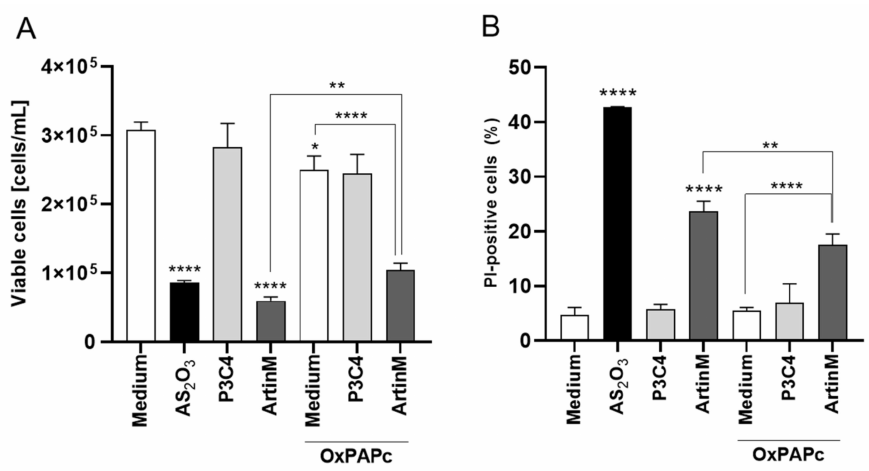
Figure 6. TLR-2 signaling blockaged by OxPAPC reduced the Raji cells apoptosis induced by ArtinM. Raji cells (1 × 10 5 cells/mL), seeded in 96-well microplates, were incubated with OxPAPC (30 µ g/mL) and ArtinM (1.25 µ g/mL) at the same time. After 24 h, propidium iodide (10 µ g/mL) was added to the cell culture and its incorporation was detected by flow cytometry, allowing the quantification of viable and non-viable cells. Raji cells were incubated with only medium, OxPAPC, or ArtinM as control. Additionally, Raji cells were also incubated with OxPAPC (30 µ g/mL) and Pam3Csk4 (1.25 µ g/mL) at the same time, and as control the cells were incubated with only Pam3Csk4 (1.25 µ g/mL). Arsenic trioxide (AS 2 O 3 ) at 12 µ M was used as a positive control. Based on the total cell number and the frequency of PI+ cells (dead cells, black bars) measured by flow cytometry, the concentration of viable cells ( A ) and frequency of PI+ cells ( B ) were determined. The results are expressed as mean ± standard error of the mean (SEM) of three independent experiments carried out in triplicate. Significant differences compared to the medium or the ArtinM alone are shown by *, p < 0.05; ** p < 0.01; ****, p <